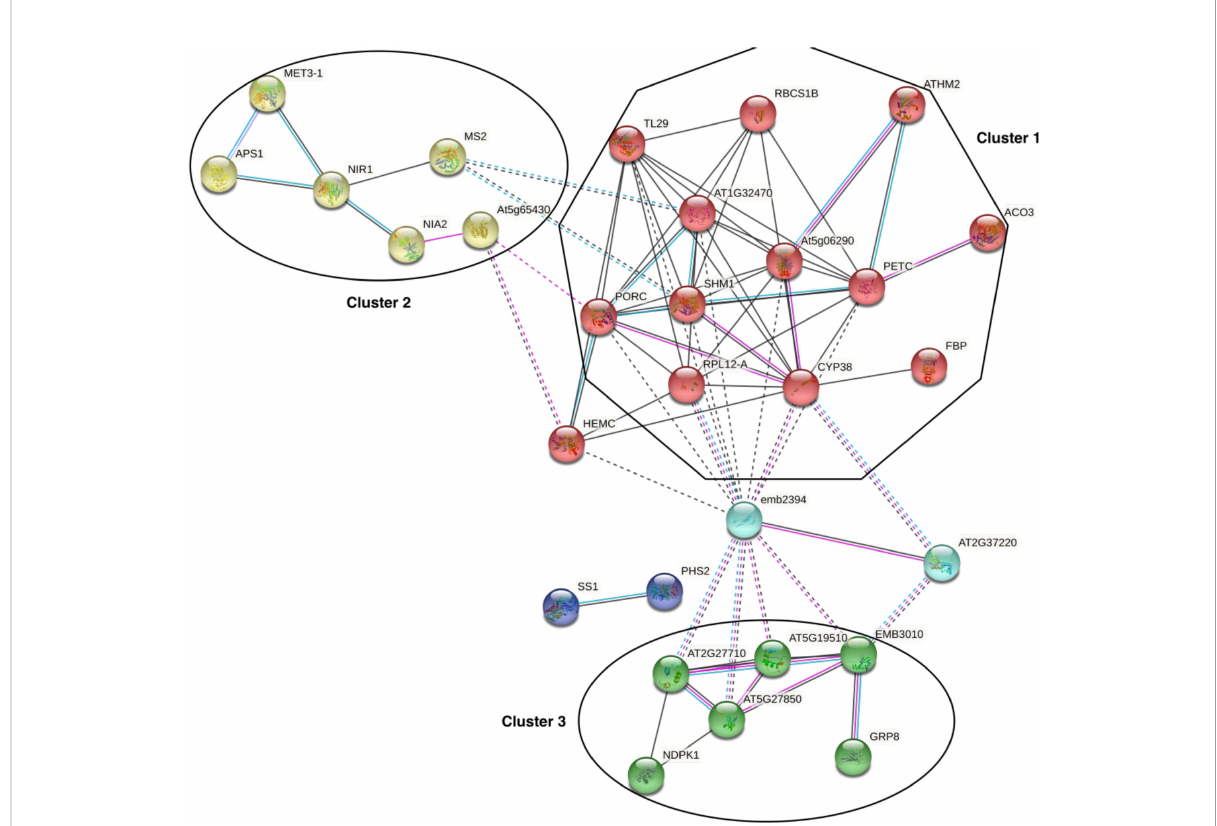
FIGURE 5 Protein-protein interaction networks infered from the carbonylated proteins. The network was generated from the STRING server by projecting the list of the H 2 O 2 -induced carbonylated proteins onto A. thaliana protein-protein interaction (PPI) data and by using only experimentally determined interactions, curated databases, and coexpression data with default settings. PPI enrichment p-value: <